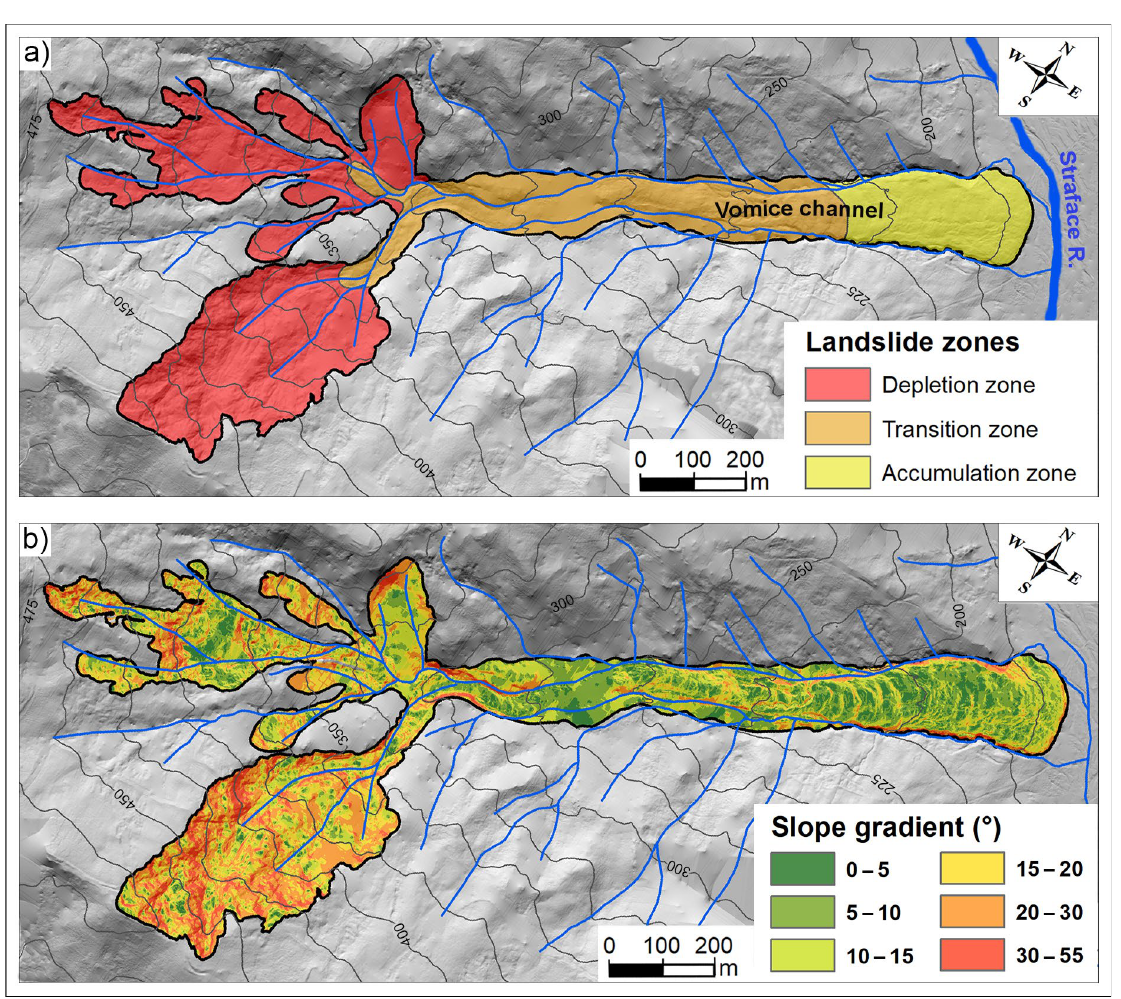
Figure 5. ( a ) Identification of the Vomice landslide zones; ( b ) slope gradient map of landslide area.